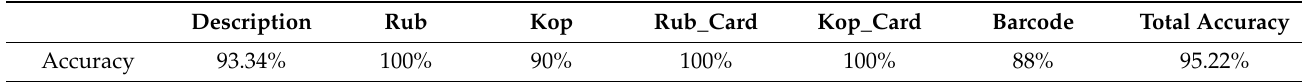
Table 2. Accuracy within a sample of 80 results.